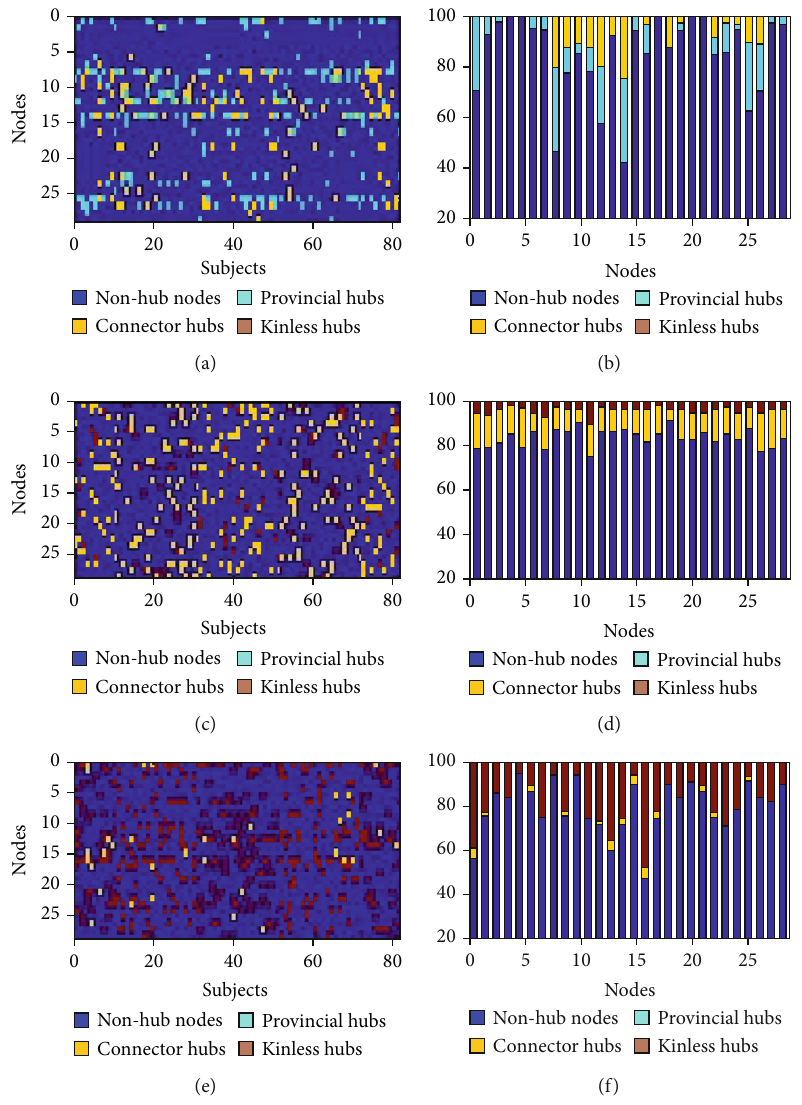
Figure 5: The hub distribution within 28 nodes of FIX (a), EMOTION (c), and WM (e) networks for 81 subjects and the subject ratio of each hub in FIX (b), EMOTION (d), and WM (f) at the threshold of 10%. The nodal order is consistent with Table 1. WM: working